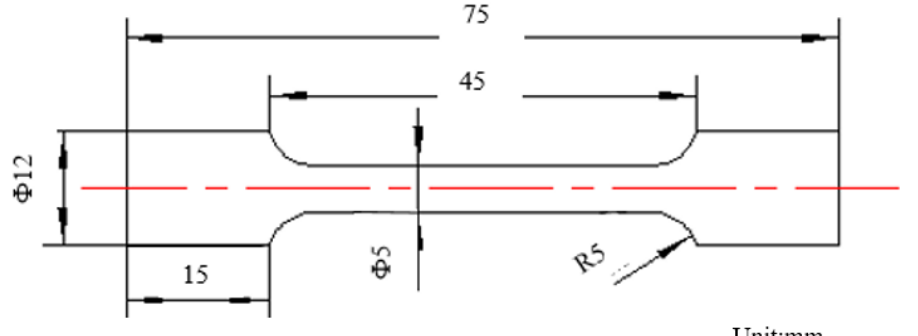
Figure 1. D structure specimen.